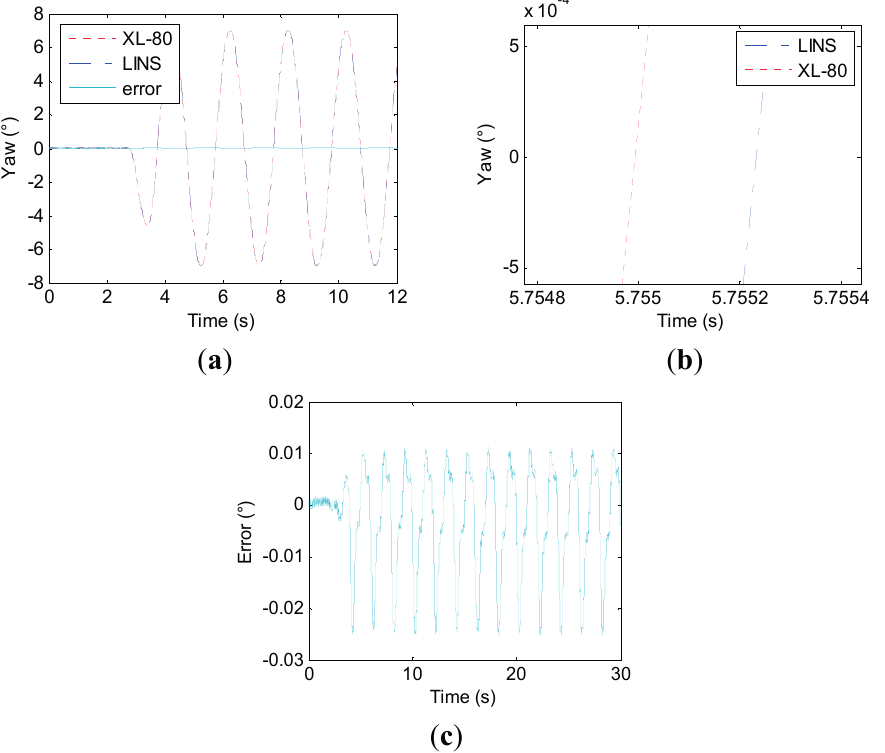
Figure 13. 6.1 t ms Δ = wobbling test results. ( a ) First 12 s wobbling test; ( b ) Phase relationship between turntable and LINS; ( c ) Error